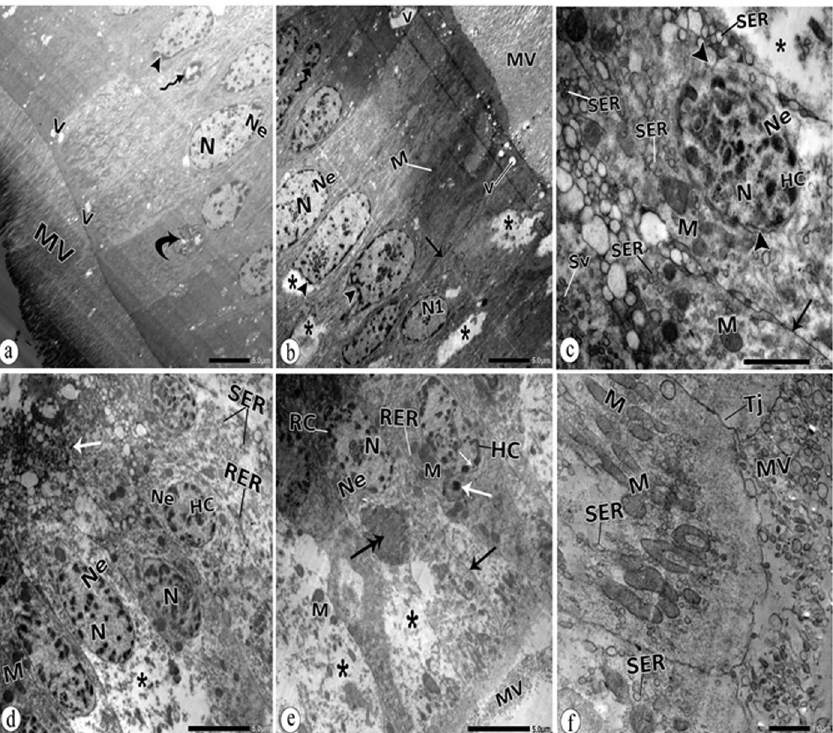
Fig 8. TEM of the treated midgut epithelium a: nucleus (N) with irregular nuclear envelope Ne (head arrow), pyknotic nucleus (wavy arrow), vacuoles (V), myelin figure (curved arrow), microvilli (MV). b: lytic cytoplasm ( � ), intended nuclear envelopes (head arrow), early apoptotic nucleus (wavy arrow), achromatic nucleus (N1), vacuoles (V), microvilli (MV). N: nucleus, Ne: nuclear envelope. c: lytic cytoplasm ( � ) heterochromatic nucleus (N), heterochromatin (Hc), karyorrhexis (head arrow) at the nuclear envelope (Ne), swollen mitochondria (M), dilated smooth endoplasmic reticulum (SER), secretory vesicle (Sv). d: lytic cytoplasm ( � ), nucleus (N), heterochromatin (Hc), nuclear envelope (Ne), electron-dense particles (white arrow), mitochondria (M), dilated smooth endoplasmic reticulum (SER), rough endoplasmic reticulum (RER). e: lytic cytoplasm ( � ), electron-dense particles (white arrow), heterochromatin (Hc), irregular nuclear envelope Ne (head arrow), swollen mitochondria (M), aggregation of malformed mitochondria (double head arrow), ruptured cell boundary (arrow), distorted microvilli (MV). f: brush border with distorted microvilli (MV), swollen mitochondria (M), dilated smooth endoplasmic reticulum (SER), tight junction